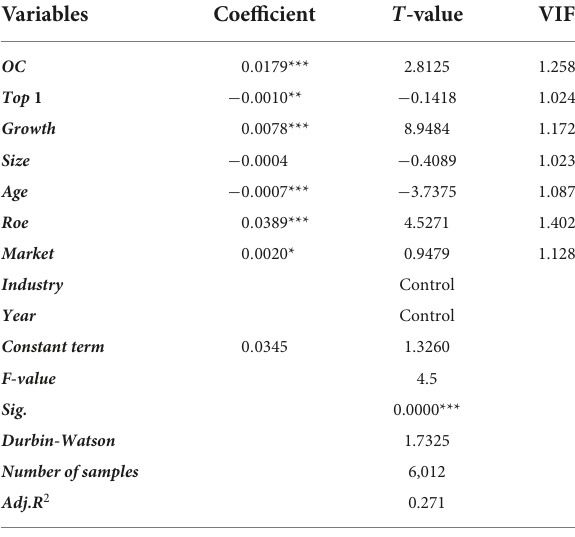
TABLE 4 Regression results of managers’ overconfidence on